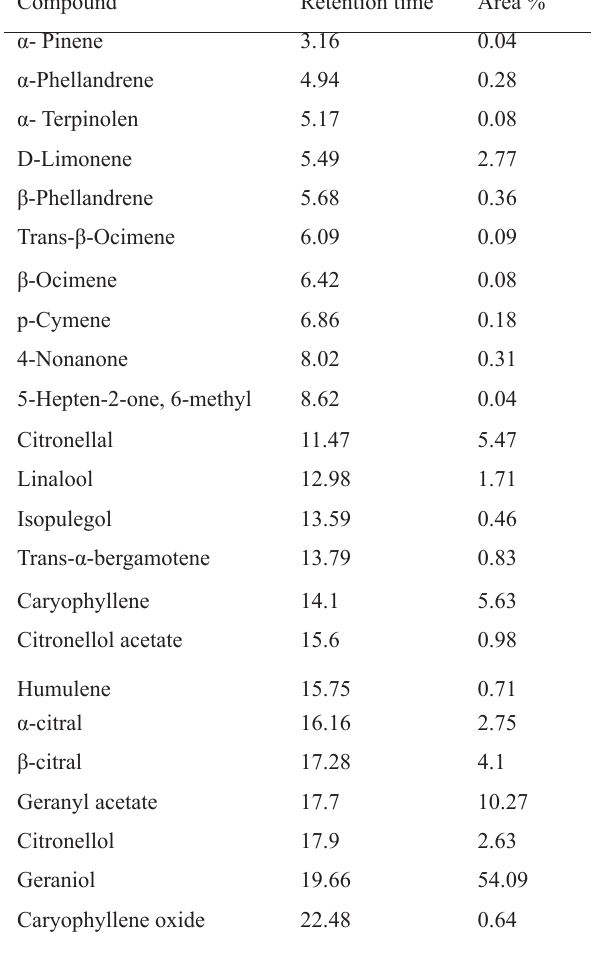
Table 3: Principal constituents of citronella oil and their relative percentages of total chromatogram